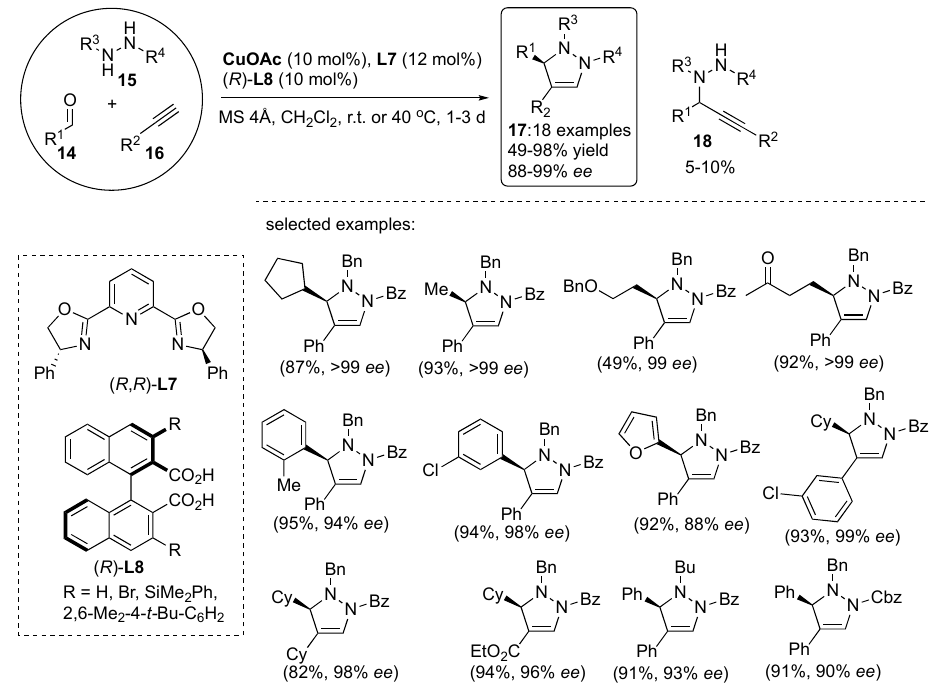
Scheme 6. Dual asymmetric induction in three-component reaction for the preparation of enantio-enriched 3,4-disusbtituted pyrazolines